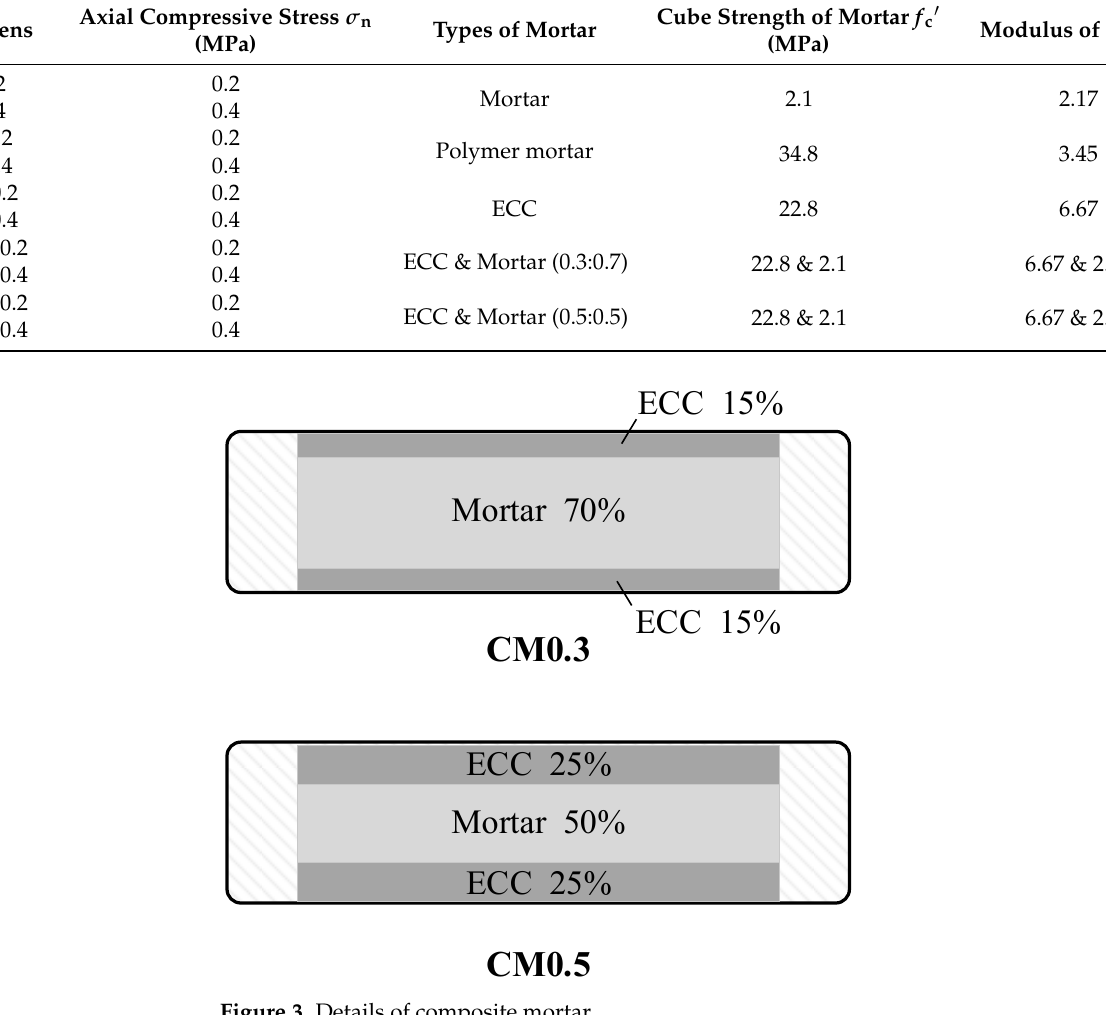
Table 1. Design parameters of the test specimens.